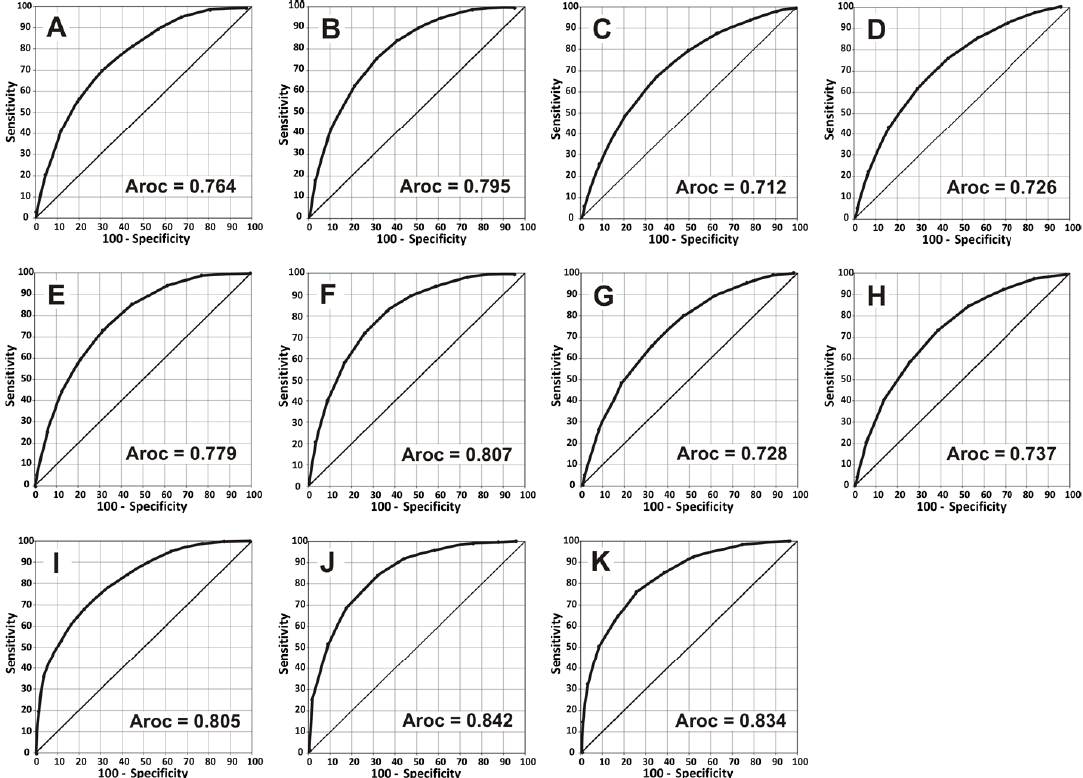
Fig. 5. ROC curves obtained with: square cells and grouped variables for tested sampling area, (A) All area; (B) Transects; (C) Buffer 1 / 1; (D) Buffer 1 / 2; square cells and dummy variables for tested sampling area, (E) All area; (F) Transects; (G) Buffer 1 / 1; (H) Buffer 1 / 2; slope units and dummy variables for tested landslide frequency thresholds (Flt), (I) Flt > 5%; (J) Flt > 20%; (K) Flt >